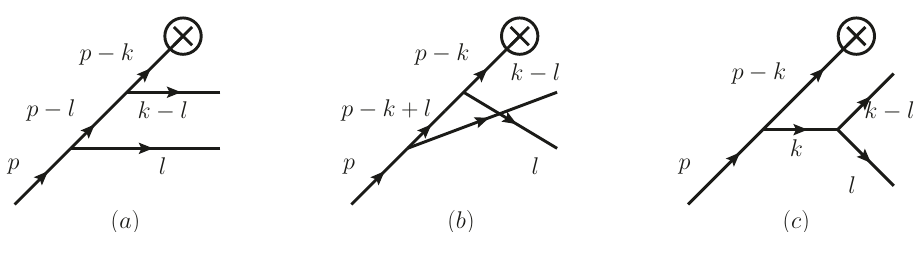
Figure 6 . Topologies for the double-real